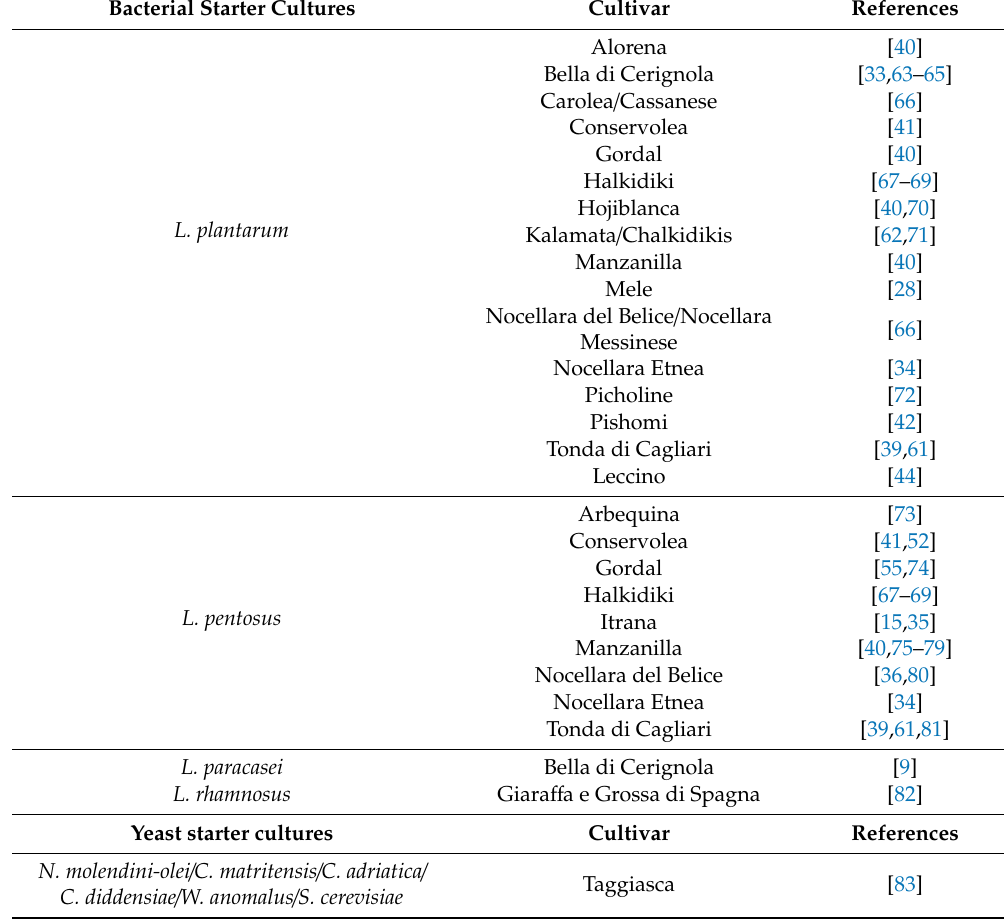
Table 3. Main starter strains used for table olive